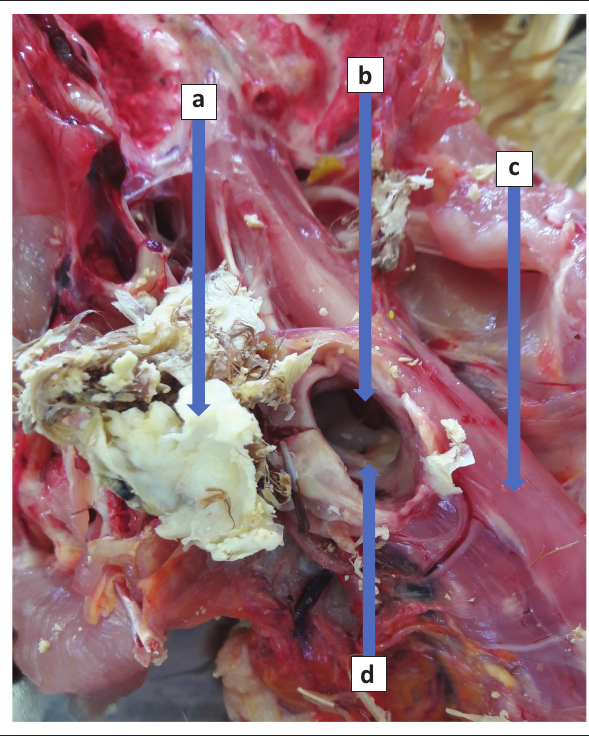
FIGURE 1: The feather cyst (a) after removal from a foramen (b) through the cervical vertebrae (c) causing compression of the cervical spinal cord (d).